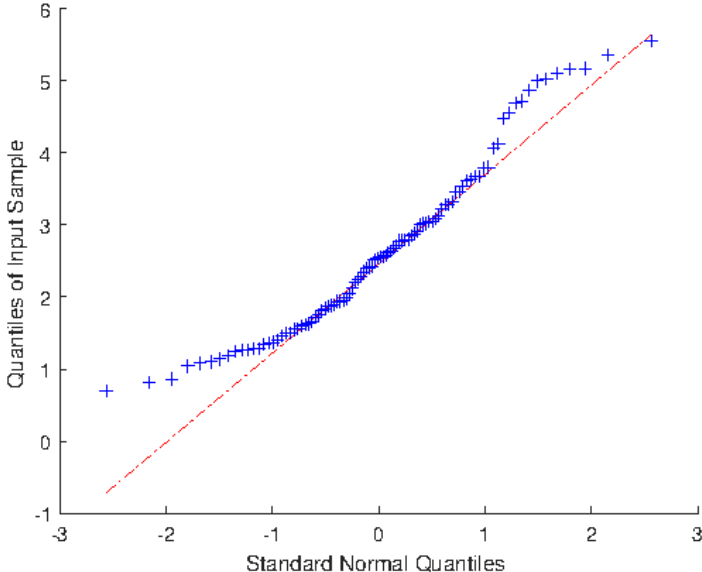
Figure 1. Q-Q plot of LAI data (Red line and blue line respectively denote the standard normal quantiles and sample quantiles).